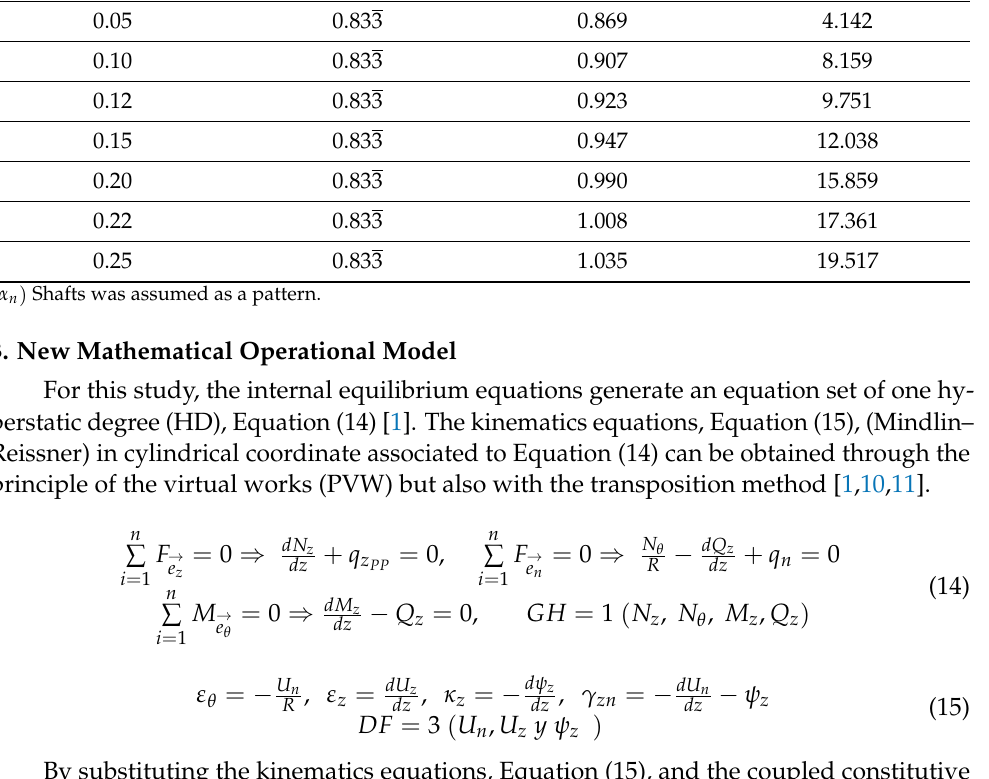
Table 1. Comparison between the new shear correction factor for tunnel ventilation shafts, and the shear correction factor for plates for different slenderness ratios ( h ) α n = 5 R